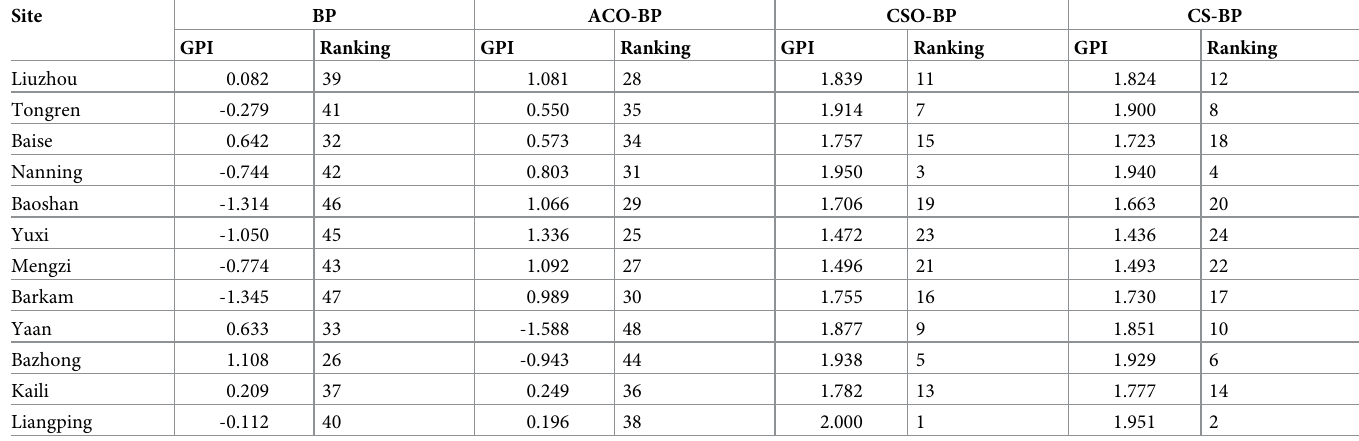
Table 2. GPI value and GPI ranking of each